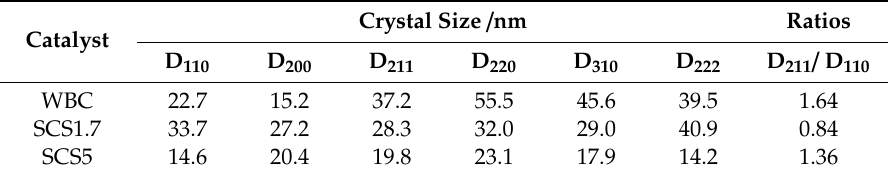
Table 2. Crystal size of reduced